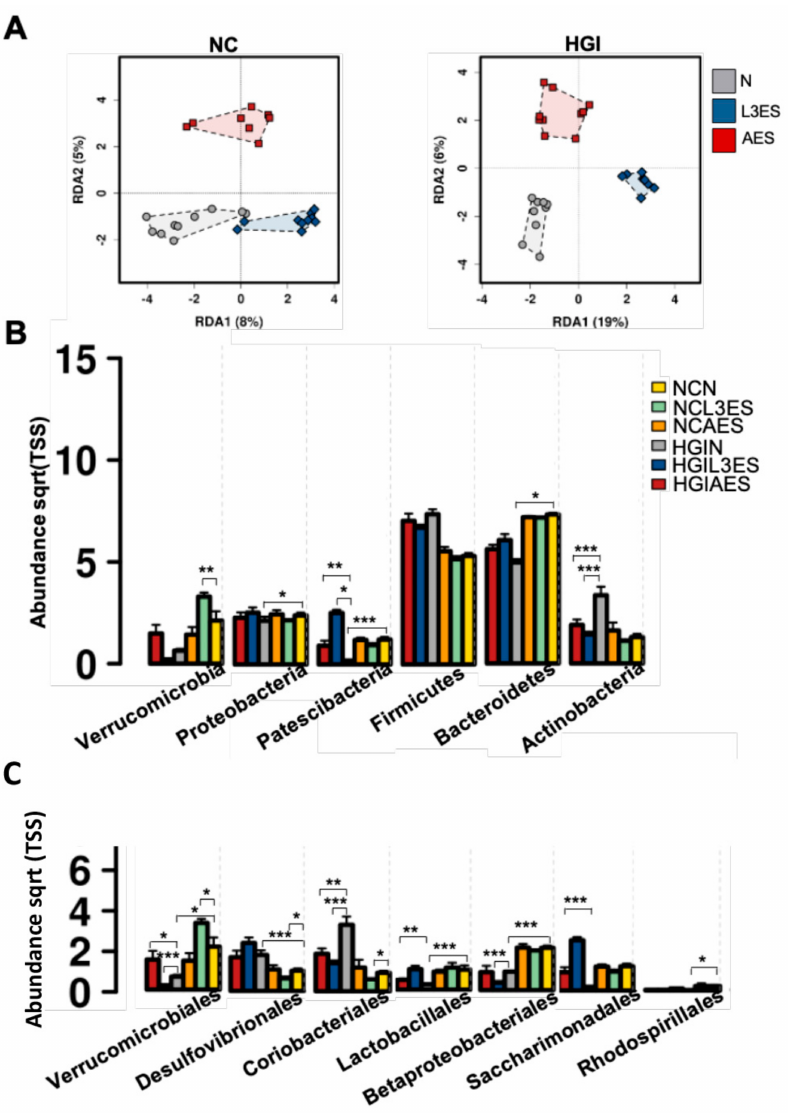
Figure 4. Multivariate analysis of differences in the microbial profiles in the small intestine of mice fed a normal control (NC) or high glycaemic index (HGI) diet and treated with excretory/secretory (ES) products from Nippostrongylus brasiliensis third-stage larvae (L3ES) or adult worms (AES): ( A ) Relative abundance of bacterial phyla in the small intestine of mice fed on NC or HGI diets and treated with L3ES or AES ( B ); Relative abundance of defined bacterial orders in the small intestine of mice fed a NC or HGI diet and treated with L3ES or AES ( C ). p -values are based on ANOVA-like differential expression analysis and are from 2 pooled experiments where n = 5/group for each